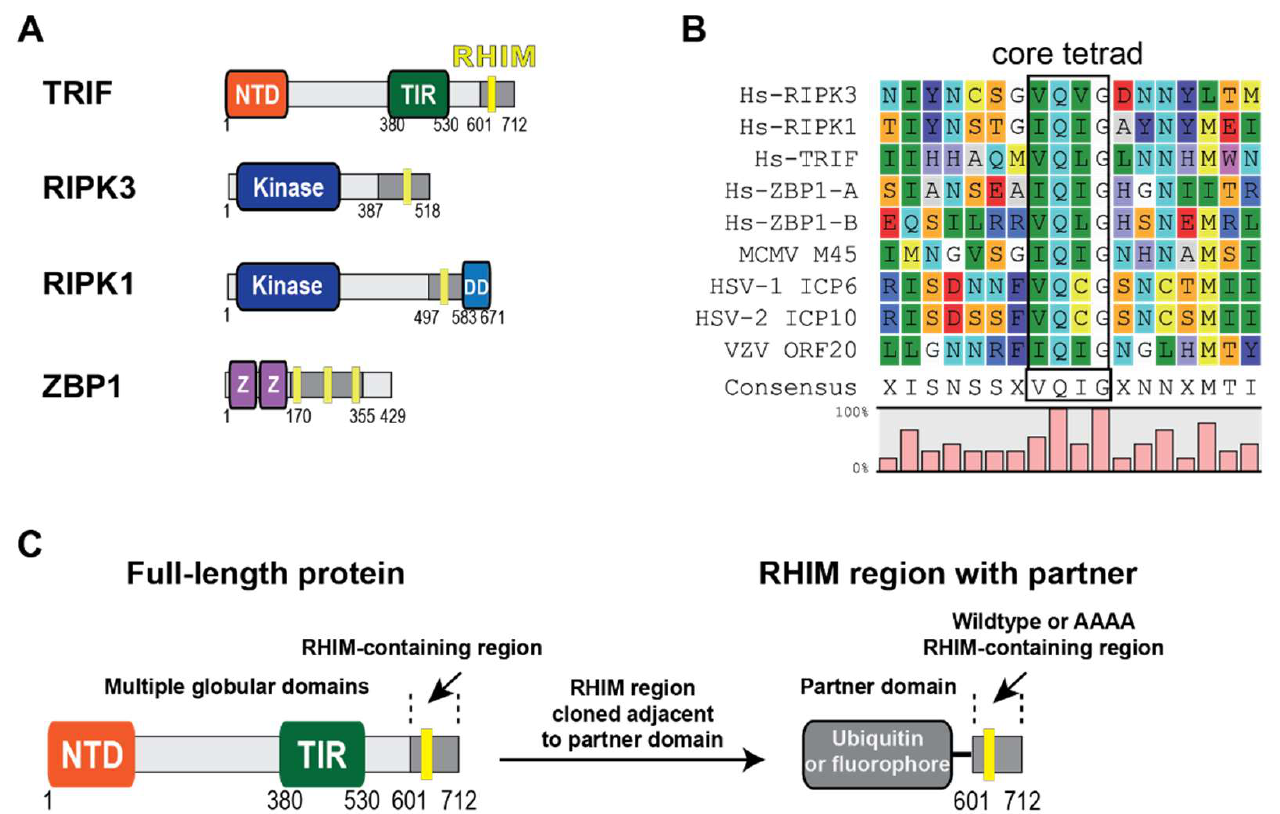
Figure 1. ( A ) Domain architecture of human RHIM-containing proteins, which contain multiple globular domains that serve diverse functional roles. RHIMs are present within disordered protein regions. Z: Z α domain; DD: death domain; NTD: N-terminal domain; TIR: Toll/interleukin-1 (IL-1) receptor domain. ( B ) Alignment of RHIM sequences from human and virus proteins. ZBP1 contains at least two RHIMs, presented as RHIM-A and RHIM-B. The conserved core tetrad is indicated in the boxed region. ( C ) Design of recombinant RHIM-containing fusion proteins with RHIM-containing regions required for necroptosis (light grey) and ubiquitin or fluorescent partner domain.